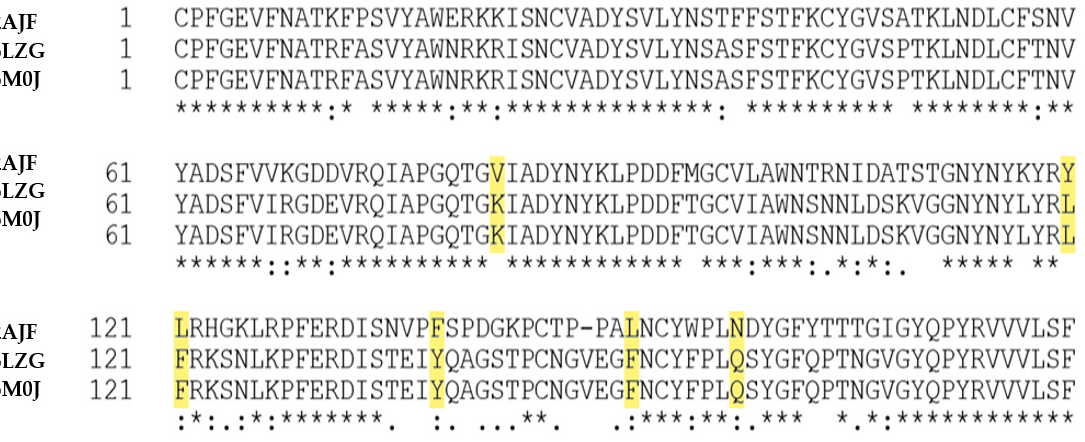
Figure 3. Comparison of the SARS-CoV-RBD/hACE2 and SARS-CoV-2 RBD/hACE2 binding sites.